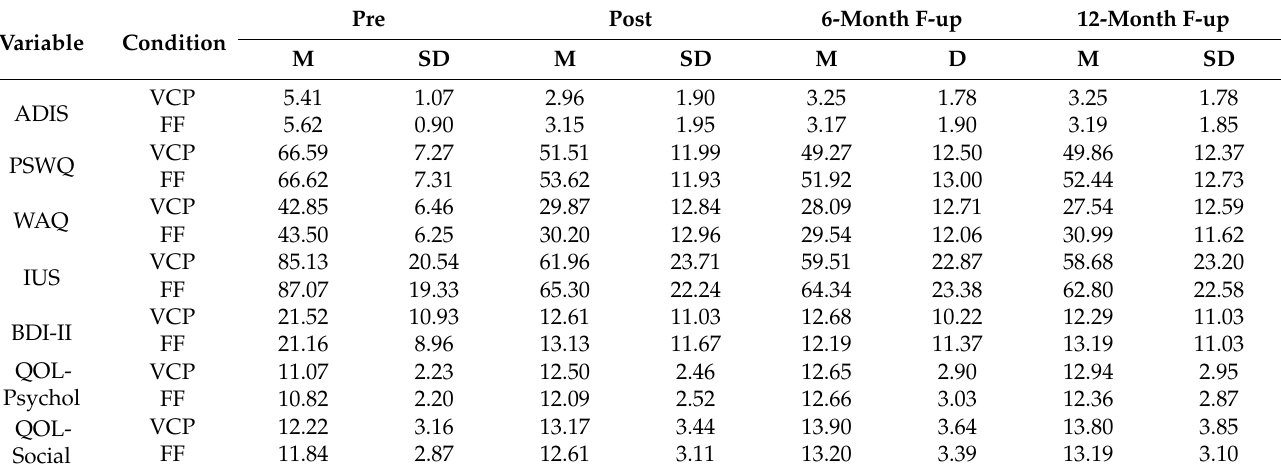
Table 2. Descriptive statistics for variables used in the non-inferiority analyses (intent-to-treat) ( n =